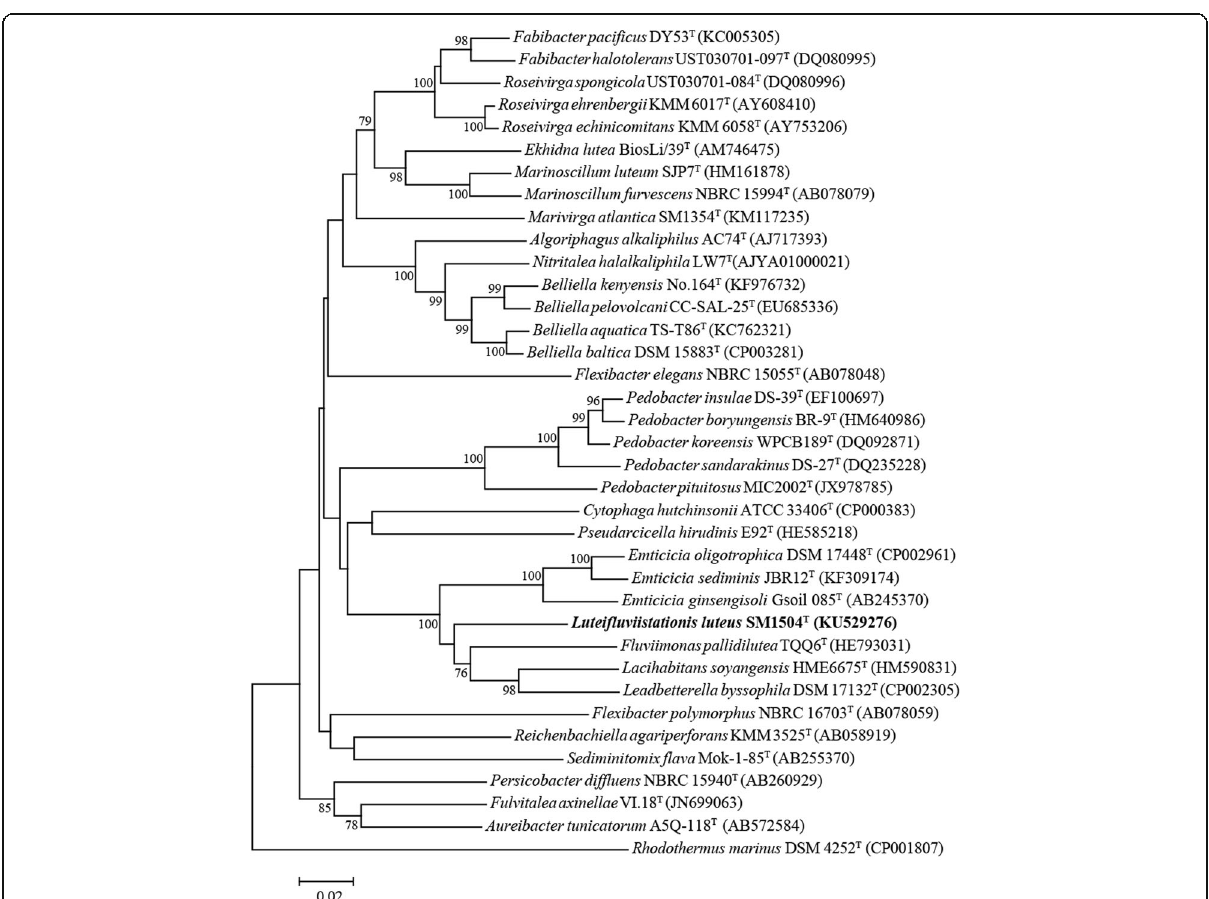
Fig. 2 Neighbor-joining phylogenetic tree based on 16S rRNA gene sequences, showing the relationships of Arcticibacterium luteifluviistationis SM1504 T and its taxonomic neighbors. Rhodothermus marinus DSM 4252 T was used as as the outgroup. Bootstrap values (> 70%) based on 1000 replicates are shown at nodes. Bar, 0.02 substitutions per nucleotide position